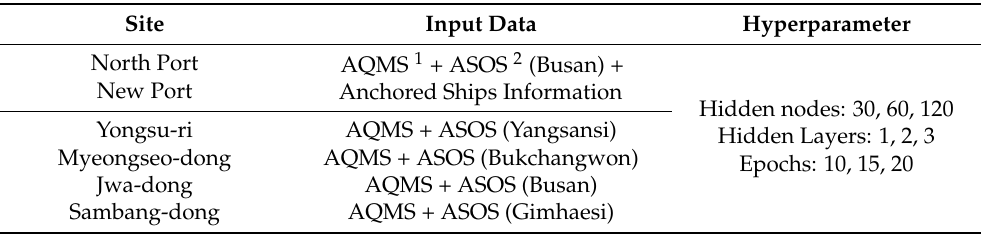
Table 6. Air quality prediction sites (learning and verification period: 1 January 2019 to 31 January 2020; prediction period: 1 February 2019 to 29 February